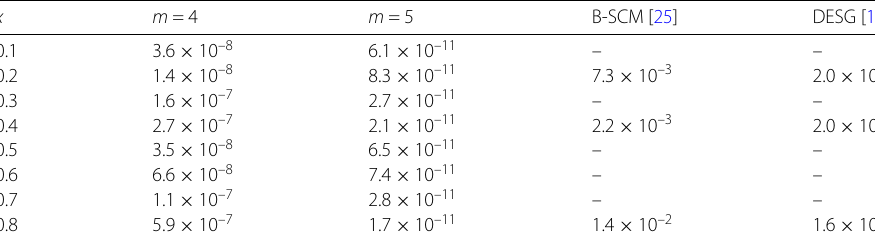
Table 9 (cid:13) (cid:24) (cid:13) L attained by proposed approaches 2 λ = 0.5 λ = 1 λ = 5 Approach I 1.52 × 10 –9 Approach II m =